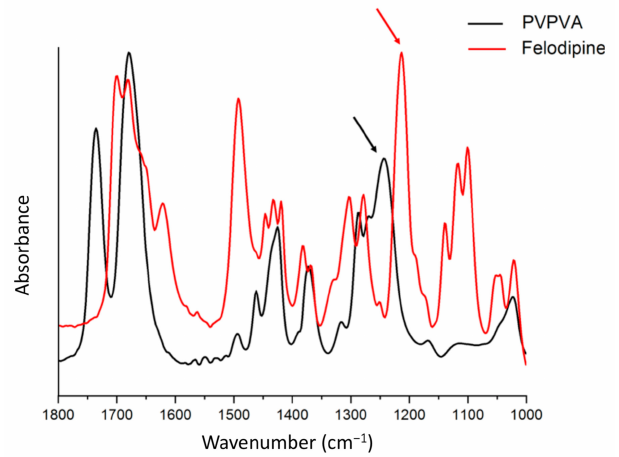
Figure 12. Bulk IR spectra of amorphous felodipine and PVPVA. The amorphous felodipine peak at 1213 cm − 1 (indicated by red arrow) and PVPVA peak at 1243 cm − 1 (indicated by black arrow) were used to differentiate drug-rich and polymer-rich phases in phase-separated ASD films.